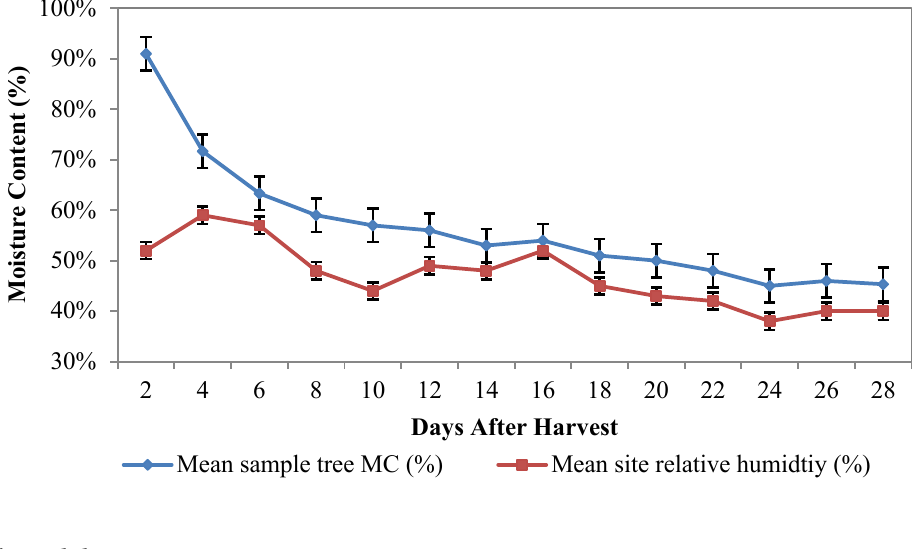
Figure 4. The changes in stem wood moisture content and site relative humidity are shown over the duration of the study; mean moisture contents and relative humidity are shown in solid shapes with error bars showing one standard